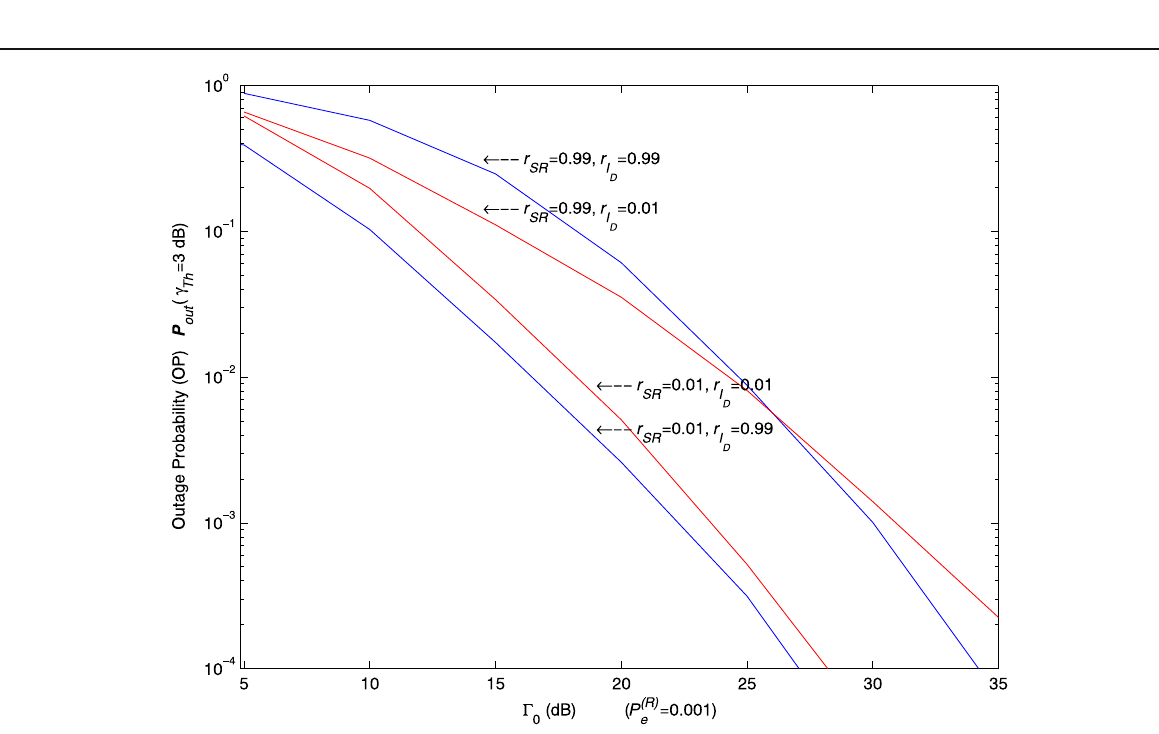
Fig. 5 The outage probability, P out ( γ Th ), for various r SR and r I ¼ 2, Γ total ¼ 10 dB, γ N I Th = 3 dB, and P 1 D